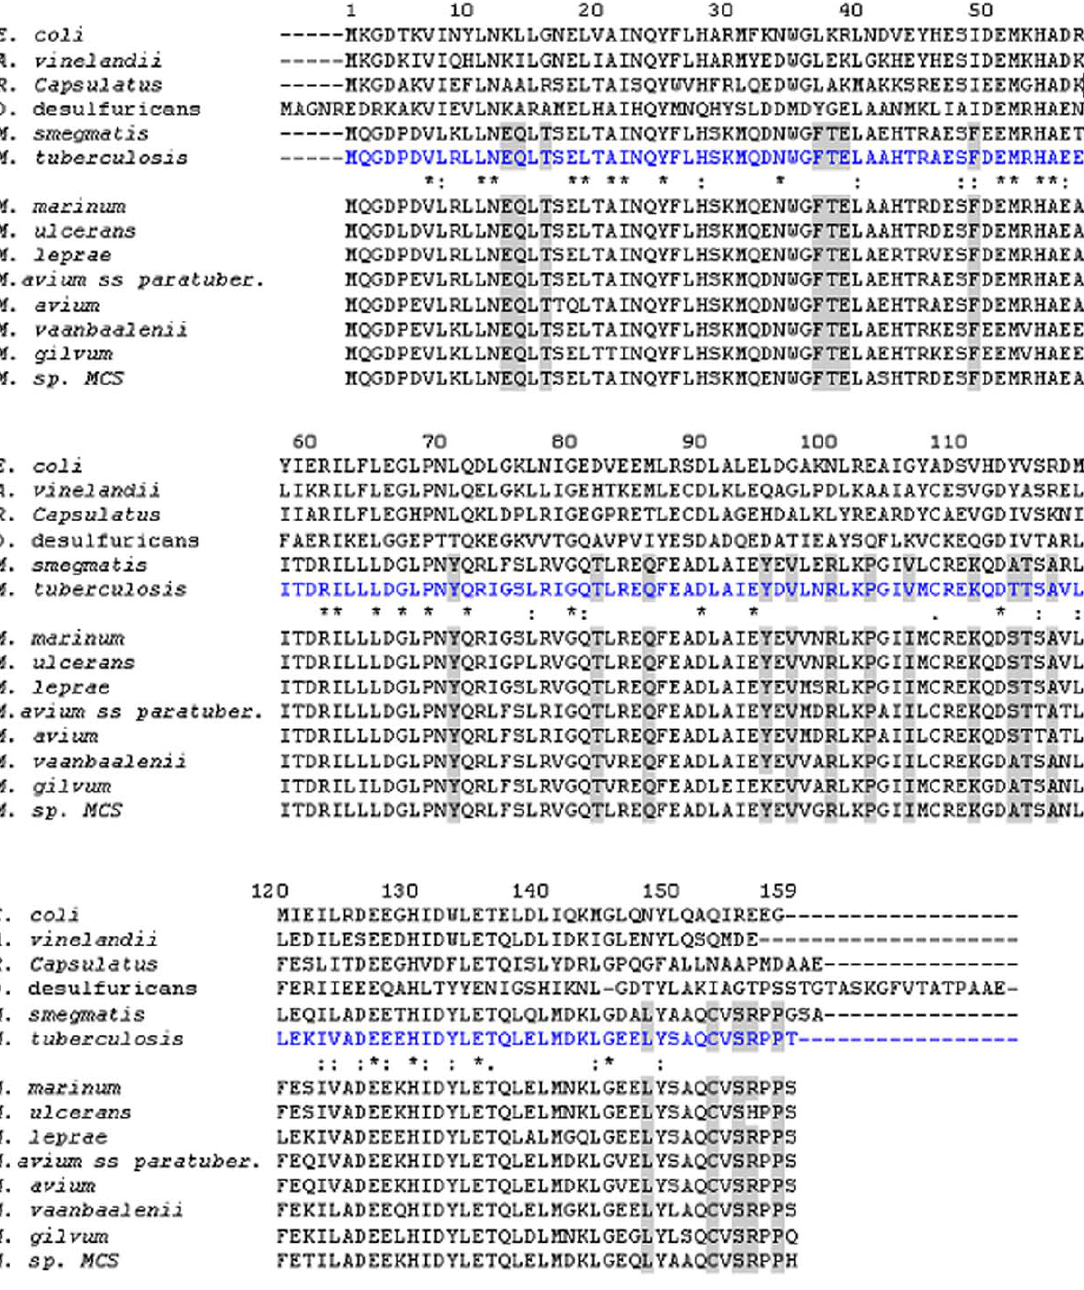
Figure 9. Amino acid sequence alignment of representative bacterioferritins. Sequences of Bfr representatives with known structures are placed above the Mtb BfrA sequence (colored blue) whereas annotated sequences from other mycobacterial species are placed below. The numbering of the residues is based on Mtb BfrA sequence. The alignment is underlined with the symbols *, :, . describing different degrees of sequence conservation in descending order. The boxes in gray represent conserved and unique residues among the mycobacterial